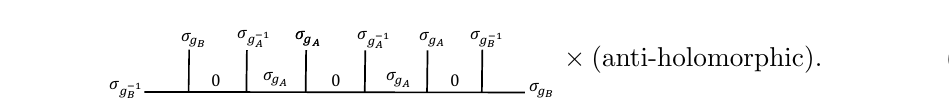
Figure 9 . This (cid:12)gure shows how the high temperature limit simpli(cid:12)es the evaluation of the correlator. In this limit, the distance between two pairs f (cid:27) g larger than other scales, therefore, only the vacuum can propagate between these two OPEs. This means that the correlator can be approximated by the vacuum